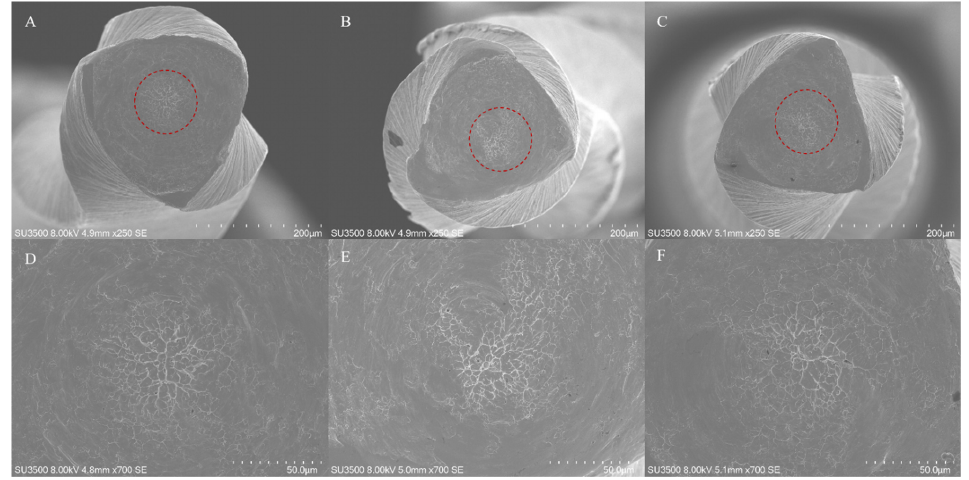
Figure 2. SEM micrographs of the fractured instruments after torsional tests. The typical fractographic pattern arising from excessive trosional load can observed in the micrographs (bottom line, ×700 magnification): central area of fibrous dimples near the center of rotation, surrounded by a peripherical zone of concentric circular abrasion marks. All SEM acquisition specifications are evidenced in each image. As shown in the images on the top (×250 magnification), all instruments are characterized by a trinagular cross-section. Upper line images: panoramic view of the fractured surfaces, ( A ) ZenFlex; ( B ) EdgeSequel Sapphire; ( C ) Vortex Blue. Bottom line images: particular of the upper images of the evidenced area (red dotted line) in which fibrous dimples near the center of rotation surrounded by concentric circular abrasion marks are evidenced at higher magnification, ( D ) ZenFlex; ( E ) EdgeSequel Sapphire; ( F ) Vortex Blue.